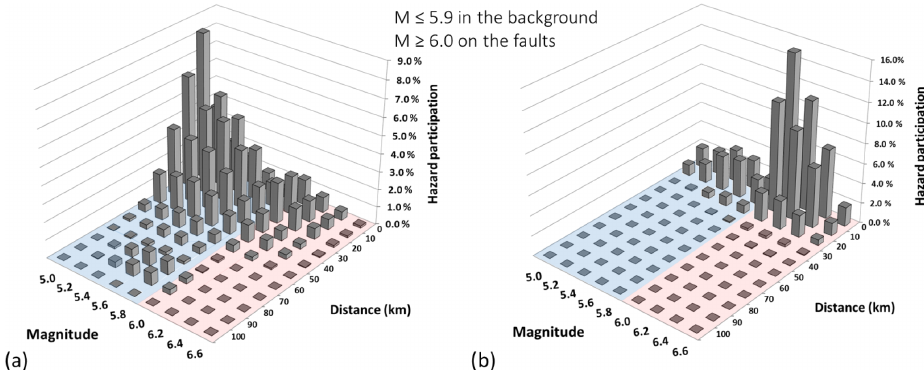
Figure 4. Seismic hazard disaggregation for PGA at return periods of (a) 475 years (PGA = 0.06g) and (b) 10000 years (PGA = 0.27g). Branch of the logic tree: active Rhine River fault, seismogenic depth of 15km, steepest dip of the faults, slowest slip rate, Gutenberg–Richter frequency-magnitude distribution and CB08.